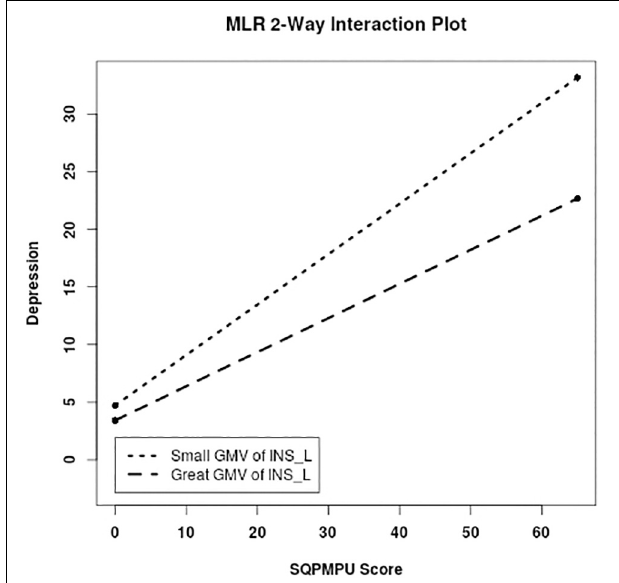
FIGURE 4 | PA-related GMV moderated the association between PMPU and psychological symptoms. Simple slopes are plotted at low (M − 1 SD) and high (M + 1 SD) GMV of the left INS that correlated to PA